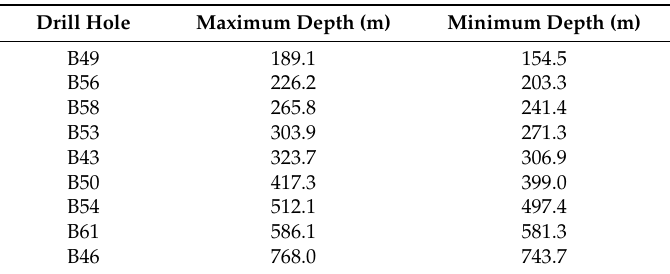
Table 1. Drill cores sampled, with depth of section